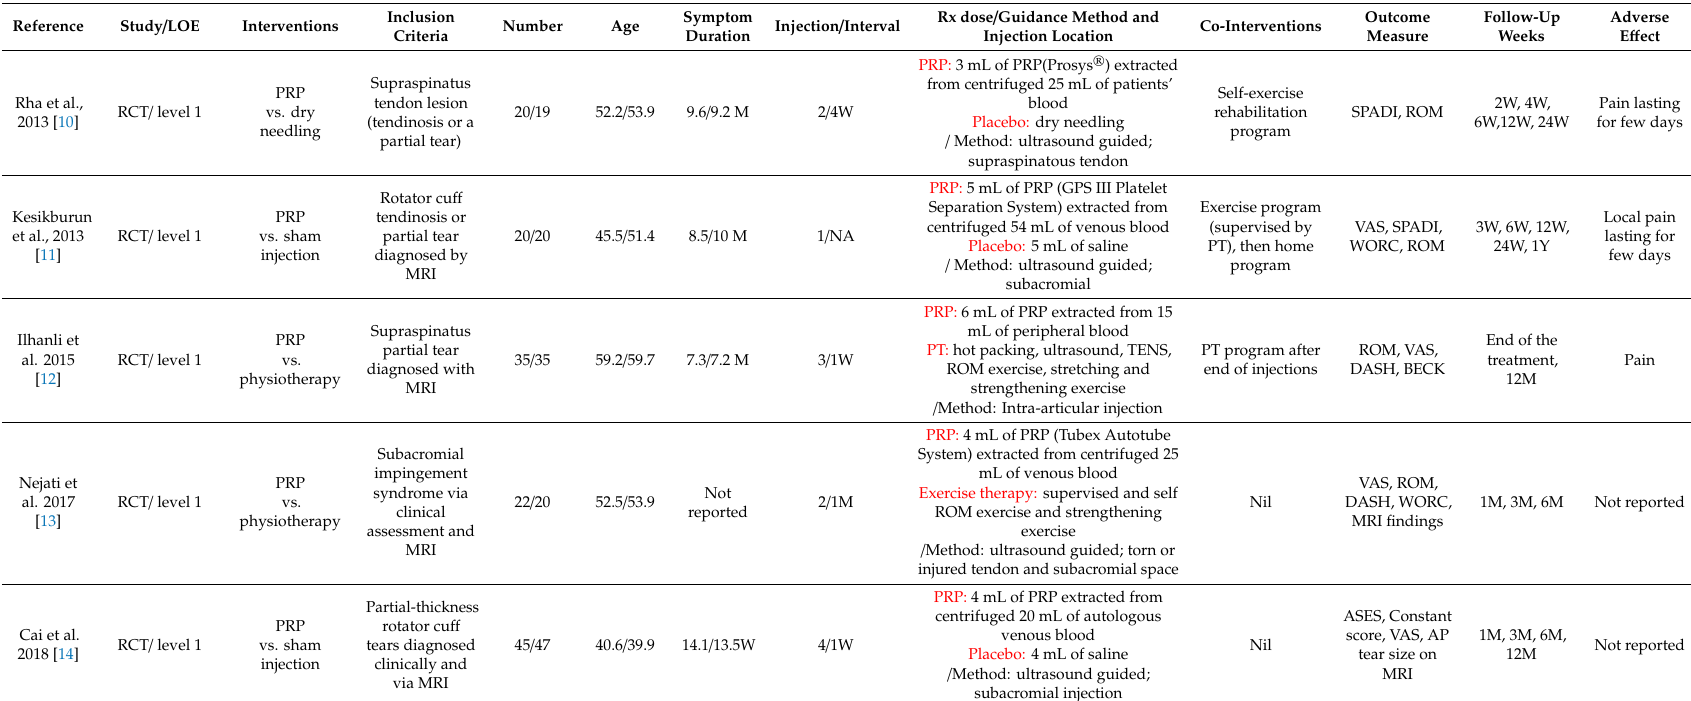
Table 1. Summary: the characteristics of included